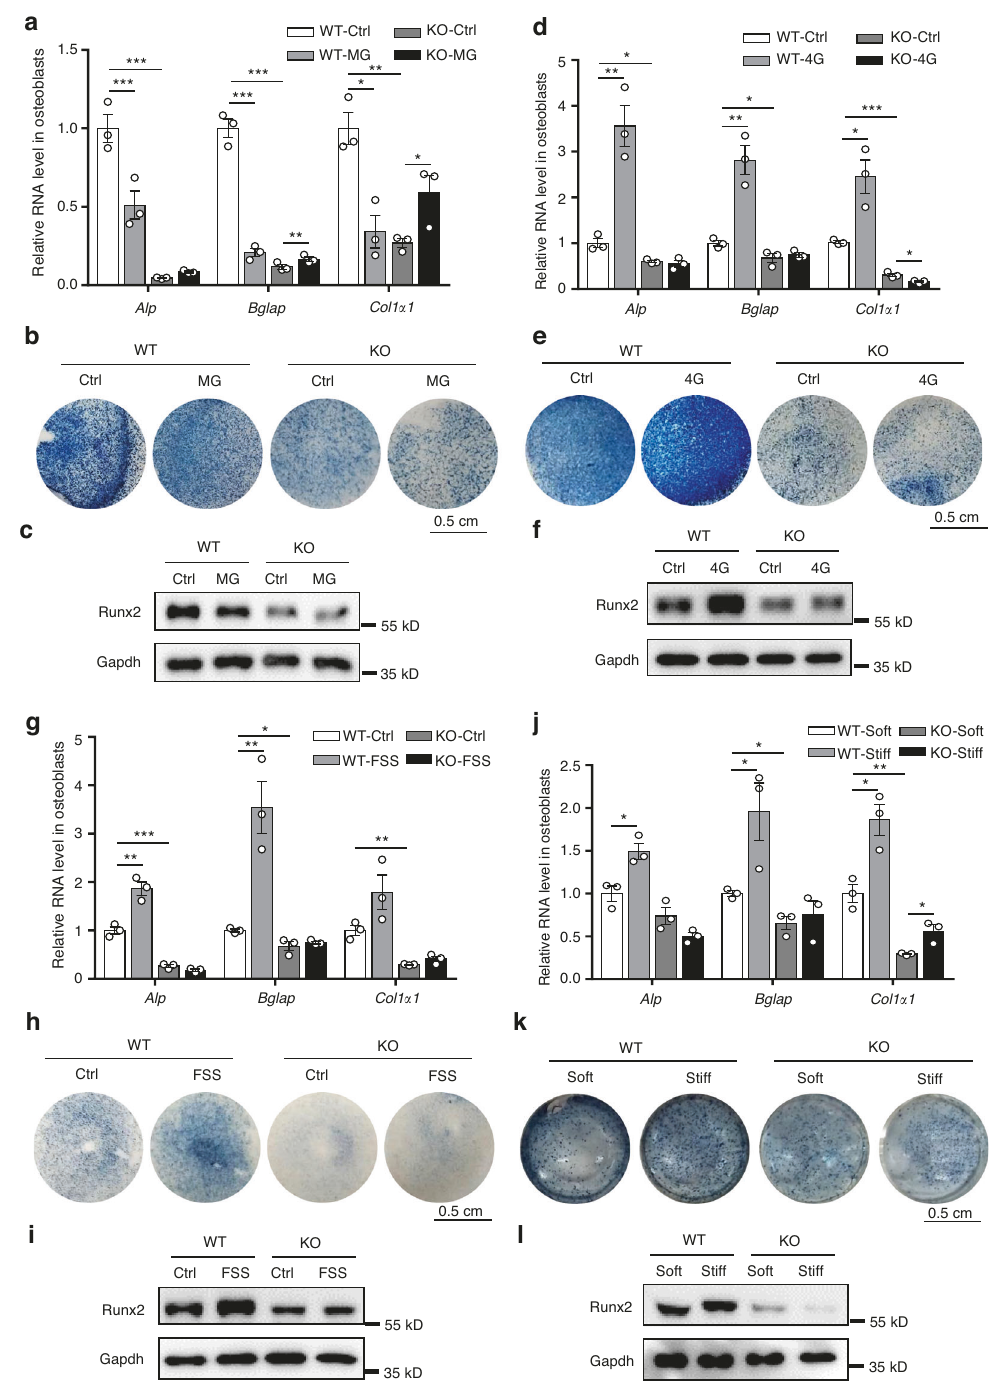
Fig. 5 Neat1 depletion in osteoblasts blunts their response to mechanical stimuli. a Analysis of the expression of the osteogenic marker genes Alp , Bglap , and Col1 α 1 in the WT and Neat1 -KO osteoblasts induced with osteogenic medium under MG conditions. The experiment was repeated for more than three times. b Representative results showing ALP staining of the WT and Neat1 -KO osteoblasts induced with osteogenic medium under MG conditions. c Immunoblot analysis of Runx2 protein levels between the WT and Neat1 -KO osteoblasts induced with osteogenic medium under MG conditions. d Expression of the osteogenic marker genes Alp , Bglap , and Col1 α 1 in the WT and Neat1 -KO osteoblasts induced with osteogenic medium under 4G conditions. The experiment was repeated more than three times. e Representative results showing ALP staining of the WT and Neat1 -KO osteoblasts induced with osteogenic medium under 4G conditions. f Immunoblot analysis of Runx2 protein levels between the WT and Neat1 -KO osteoblasts induced with osteogenic medium under 4G conditions. g , h . Analysis of osteogenic marker genes and ALP activity in the WT and Neat1 -KO osteoblasts treated with FSS. The results show representative data from three independent experiments. i Immunoblot analysis of Runx2 protein levels in the WT and Neat1 -KO osteoblasts after FSS treatment for 4 h. j , k Analysis of osteogenic marker genes and ALP activity in the WT and Neat1 -KO osteoblasts cultured on soft or stiff matrix. The results show representative data from three independent experiments. l Immunoblot analysis of Runx2 protein levels in the WT and Neat1 -KO primary osteoblasts cultured on soft or stiff matrix. * P < 0.05, ** P < 0.01, *** P <